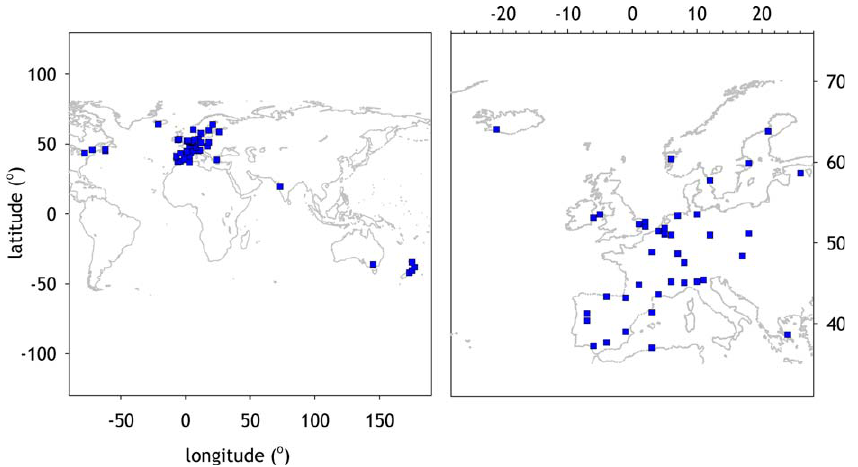
Figure 1. World Map and European Map of Study Centres DOI: 10.1371/journal.pmed.0020294.g001